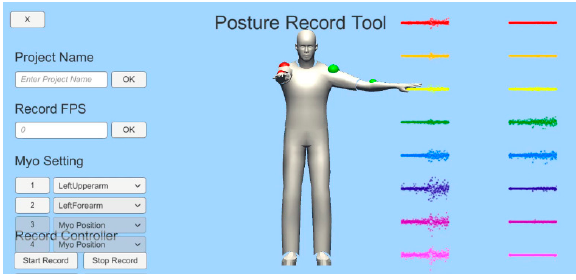
Figure 2. EMG signal recording.